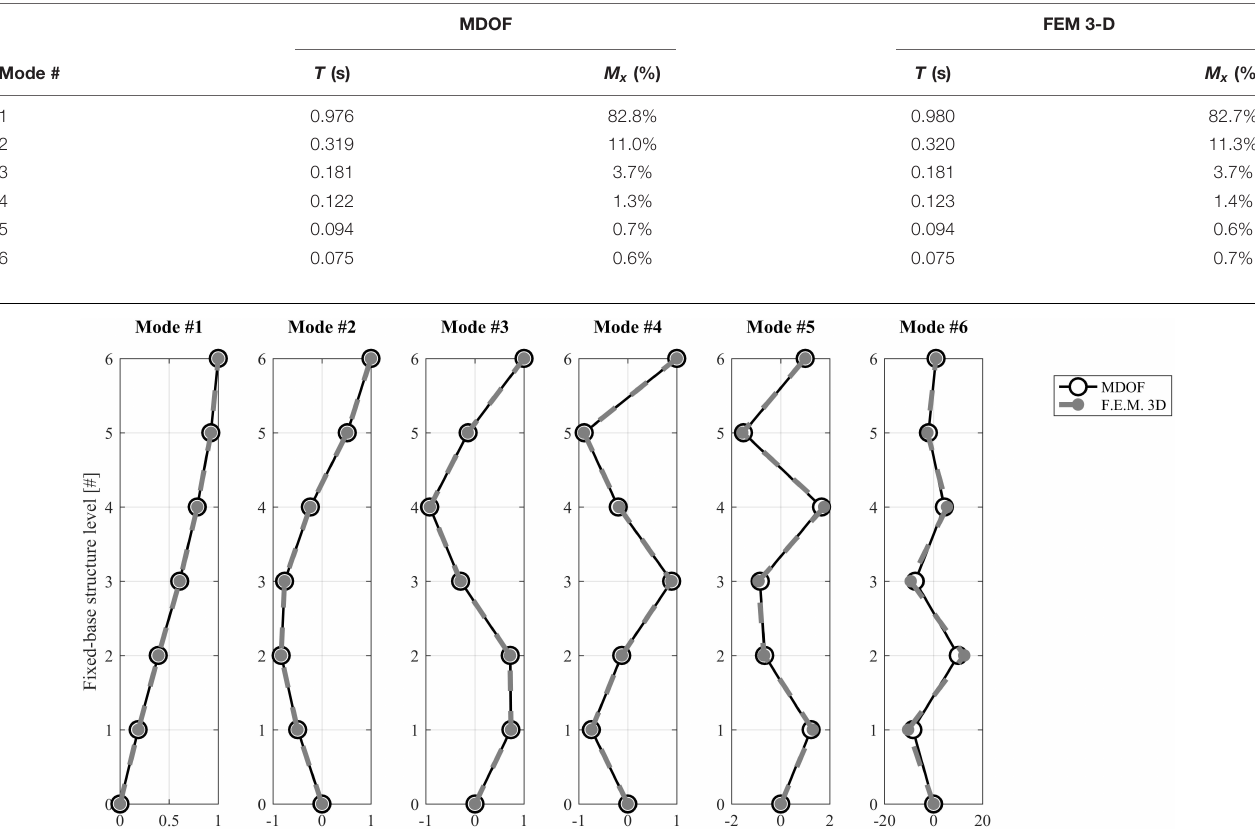
TABLE 3 | Modal analyses comparison: vibration periods and participating mass ratios.